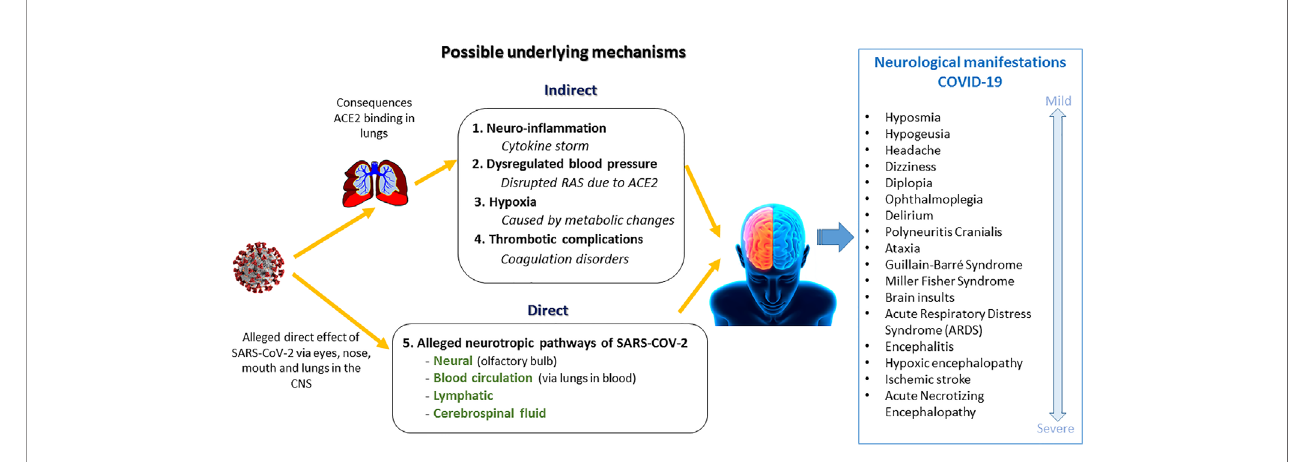
FIGURE 2 | Neurological manifestations of COVID-19 and possible